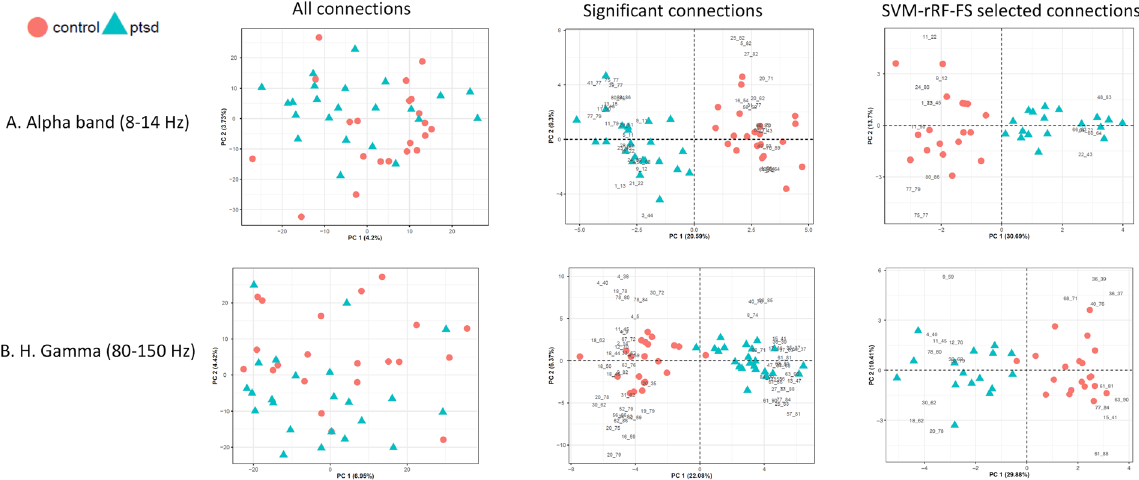
Figure 4. Score plots and biplots (i.e. score plot and loading plot) showing PCA result. For biplot, the loading plots exhibit the contribution of the edges to clustering pattern. Left column: Score plots for PCA results from all the edges; middle column: biplots for PCA results from feature-reduced data with only the significant edges (p < 0.01); right column: biplots for PCA results from data with CV-SVM-rRF-FS selected edges. ( A ) Alpha band and ( B ) H. Gamma band.